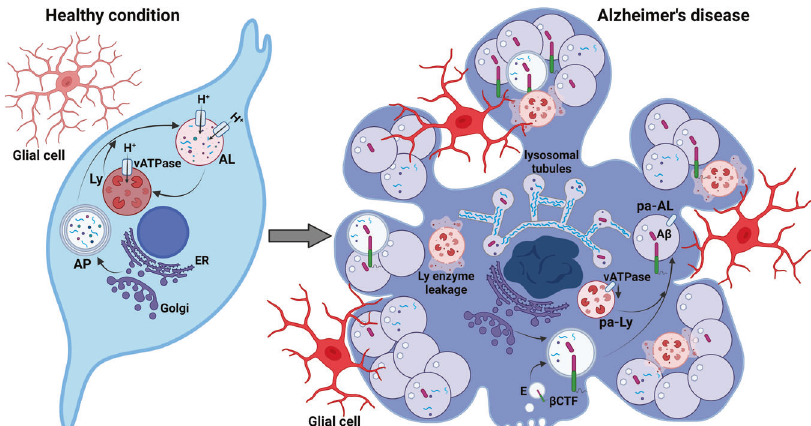
Fig. 1 PANTHOS Progression. This graphic depicts how poorly acidi fi ed autolysosomes (AL) (purple) congregate in the soma of neurons (left), pushing out the cell membrane to form petal like structures, so called PANTHOS (right). Lysosomes (Ly), the cells disassembly organelle, begin leaking proteases (pink) and A β fi brils (gray squiggles) aggregate in lysosomal tubules around the cell nucleus. By this means a packed neuron collides with nearby PANTHOS cells and ruptures (right), recruiting glia cells to turn the A β debris into larger plaques. pa-AL: poorly acidi fi ed AL; poorly acidi fi ed Lys (pa-Ly). Adapted after Lee et al., Nature Neuroscience, 2022